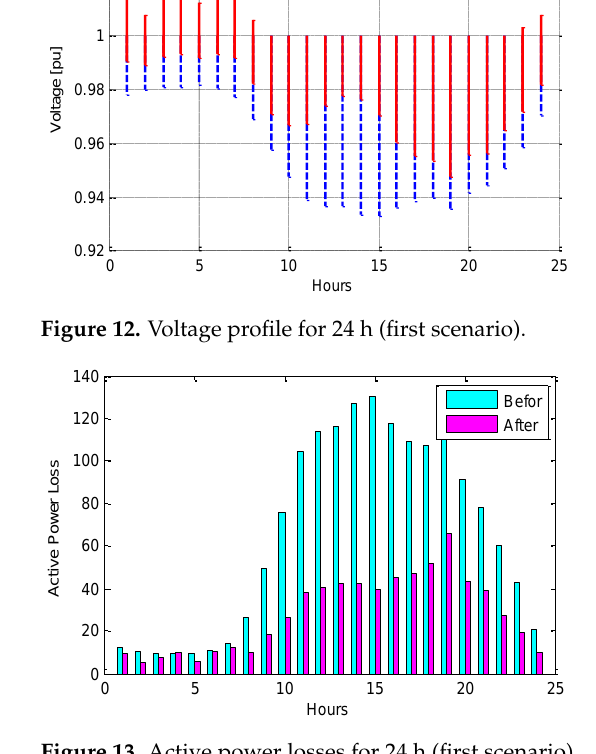
Figure 14. Reactive power losses for 24 h (first scenario).